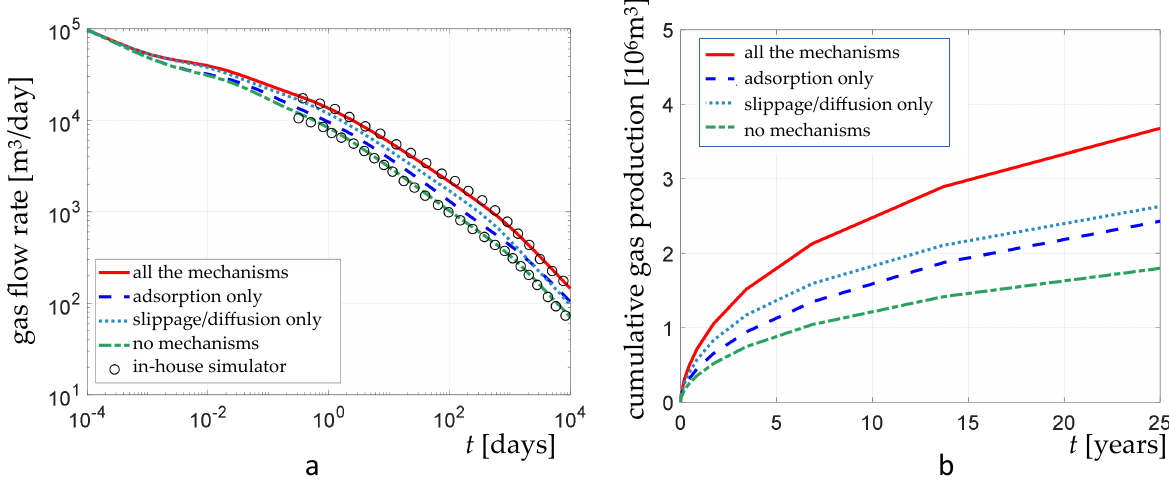
Figure 18. Gas flow rate ( a ) of VE2 and cumulative gas production ( b ) for adsorption and slippage/diffusion, adsorption only, slippage/diffusion only, and no mechanisms; comparison between ShOpen and the in-house simulator